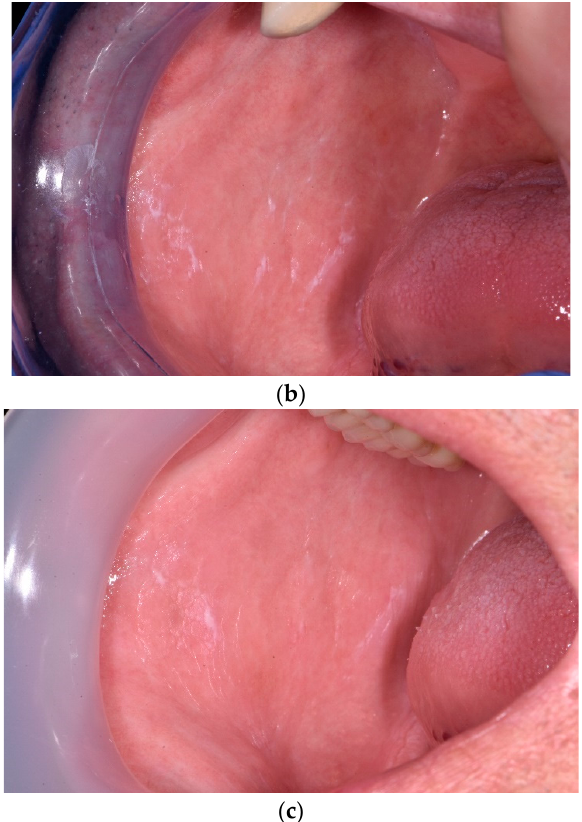
Figure 1. Changes in OLP over time. X: time of observation; T0: baseline; T1: after PDT; T2: 12 months after therapy. Y axsis: mean size of OLP lesions (cm 2 ). ( a ) Male patient, aged 61, before PDT. OLP on the right cheek. Size of the lesion: 3 cm × 3 cm; surface area: 9 cm 2 . ( b ) After PDT complete remission of the lesion on the right cheek. ( c ) Twelve months post-op - remission on the right maintained. Table 2. Mean size reduction, standard deviation, and 95% CI upon therapy completion and 12 months later.